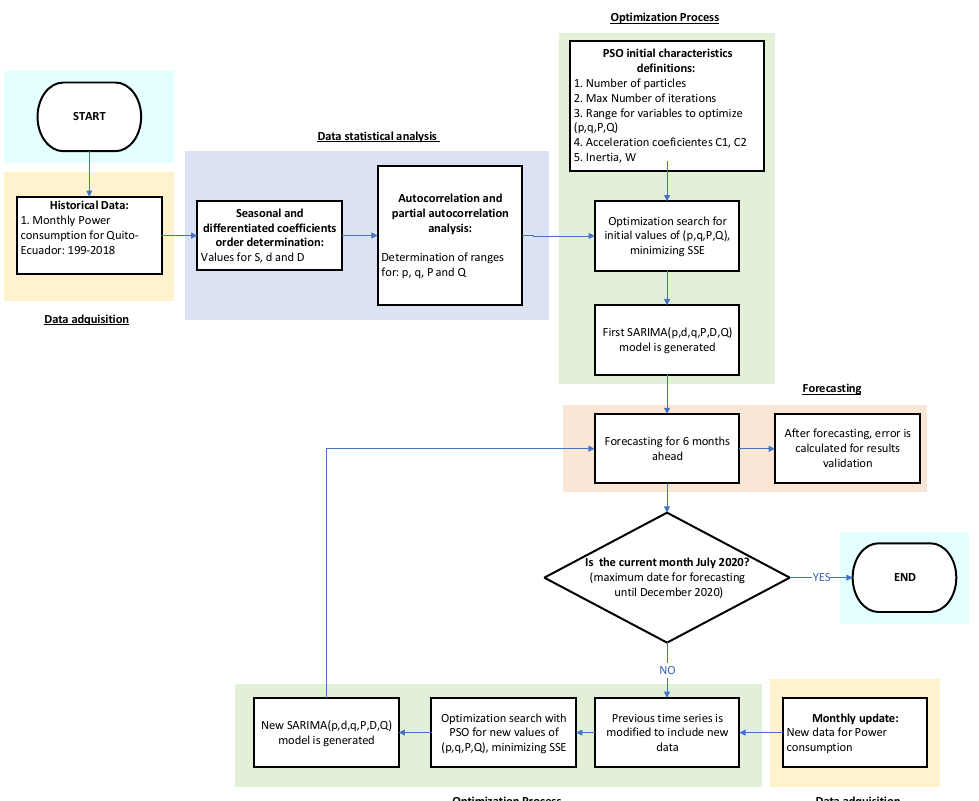
Figure 8. Methodology for adaptative forecasting of power consumption: Quito,